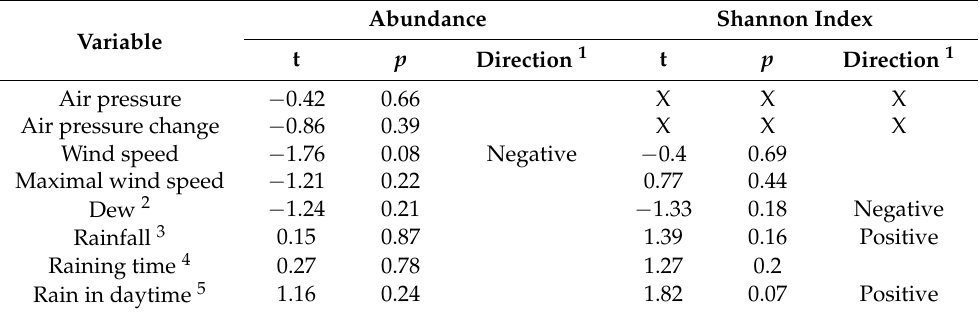
Table 5. Statistics associated with a selection of weather variables when added one by one to the definitive models for abundance (Table 4) and diversity (Table 6). These variables did not enter the definitive models but were omitted in the backward elimination procedure. The analyses in this table provide additional confirmation of the non-significance of respective effects.